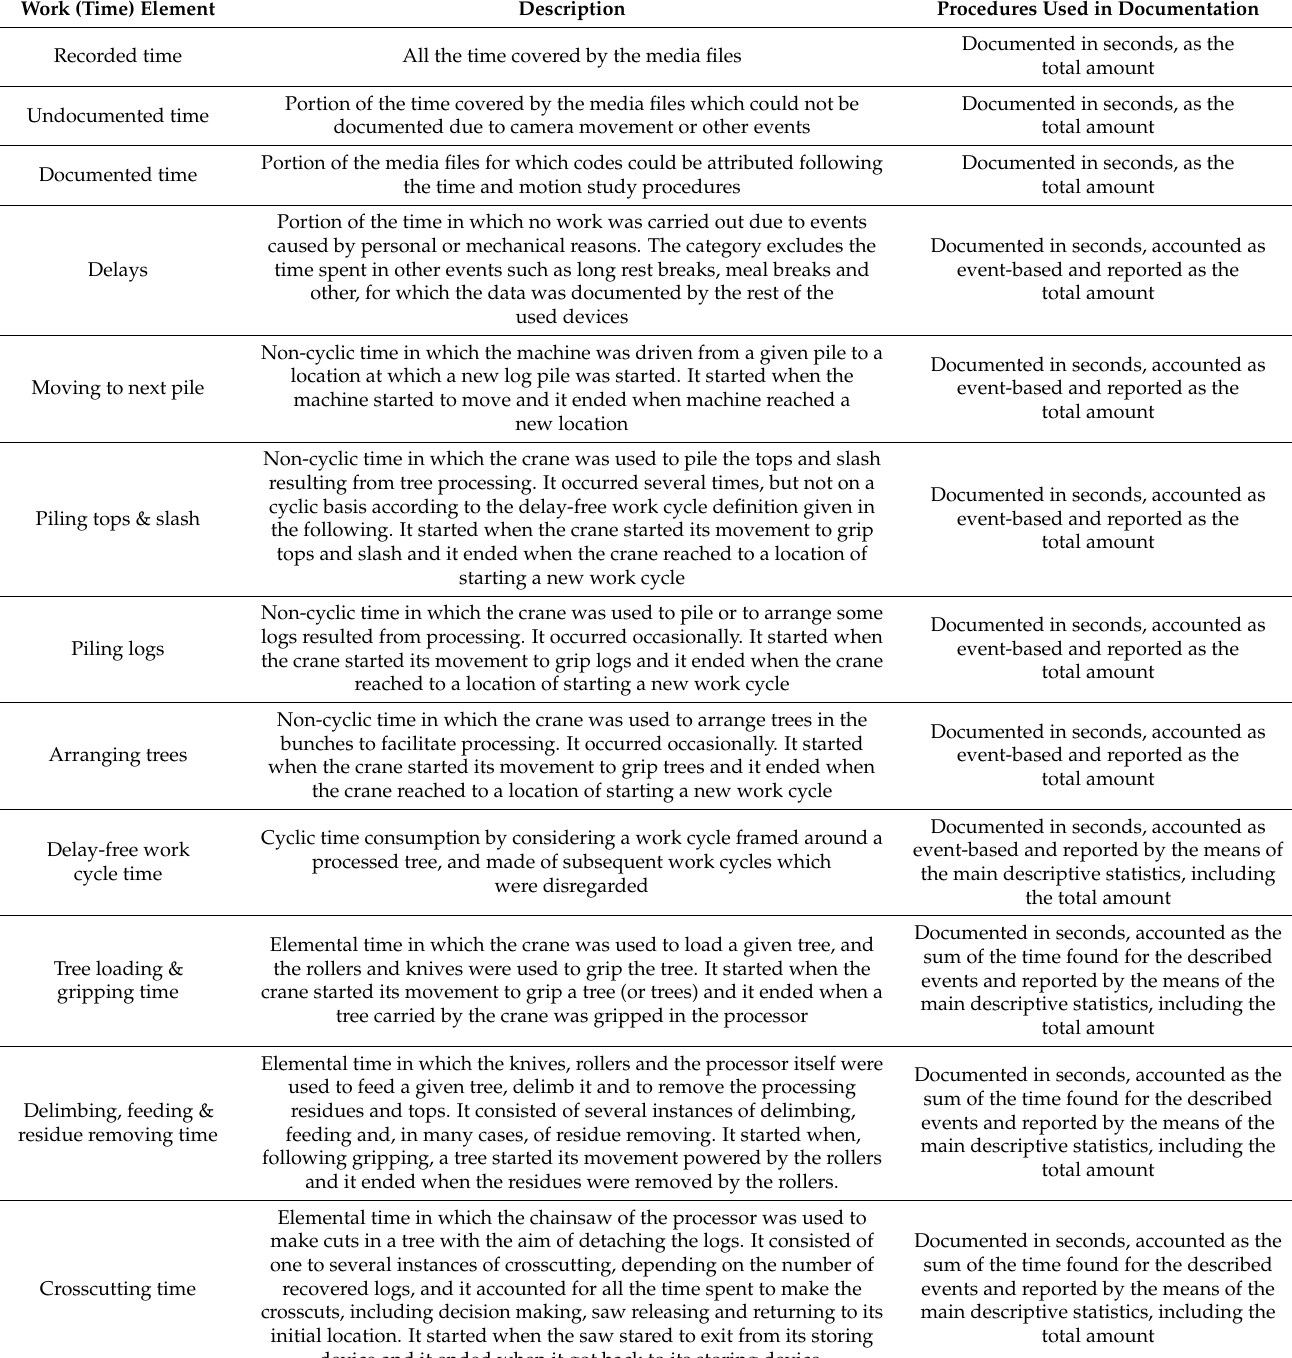
Table 1. Description of work and time